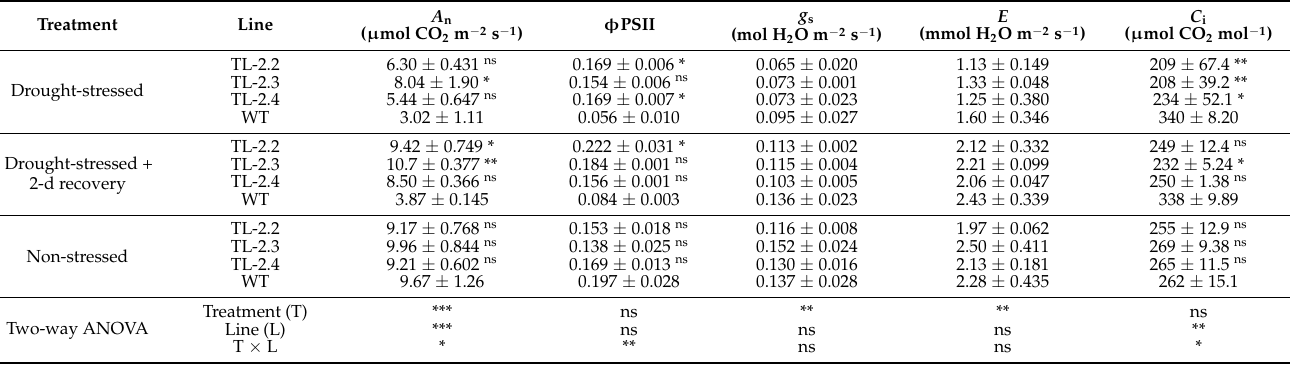
Figure 7. Plant growth under non-stressed and drought-stressed conditions. ( a ) Growth of PR10a transgenic plant under non-stressed condition, ( b , c ) PR10a transgenic plants under drought stress for two weeks, ( d ) wild-type under drought stress for two weeks. Table 6. Net photosynthetic rate ( A n ), quantum efficiency of photosystem II electron transport under 1200 µ mol m − 2 s − 1 PAR ( φ PSII), stomatal conductance ( g s ), transpiration rate ( E ), and intercellular CO 2 concentration ( C i ) of different generations of transgenic faba bean line TL-2 after 14 days of drought stress or after 14 days of drought stress followed by a 2-d recovery period. Asterisks indicate significant differences within treatment by Dunnett’s test using wild-type (WT) faba bean as control upon significant interaction indicated by two-way ANOVA. *** p < 0.001, ** p < 0.01, * p < 0.05, ns insignificance with p >